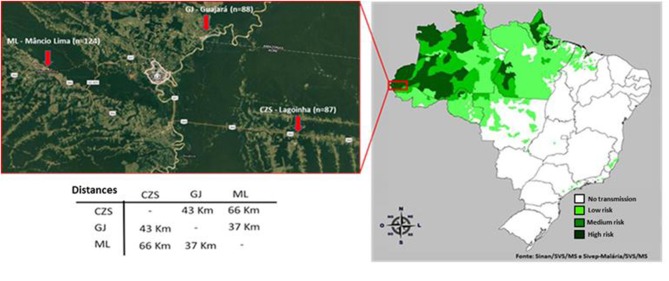
Areas of samples collection. The three areas of sample collection in the north of Brazil (state of Acre) are approximately fifty kilometers apart from each another. CZS, Cruzeiro do Sul; GJ, Guajara; and ML, Mancio Lima.